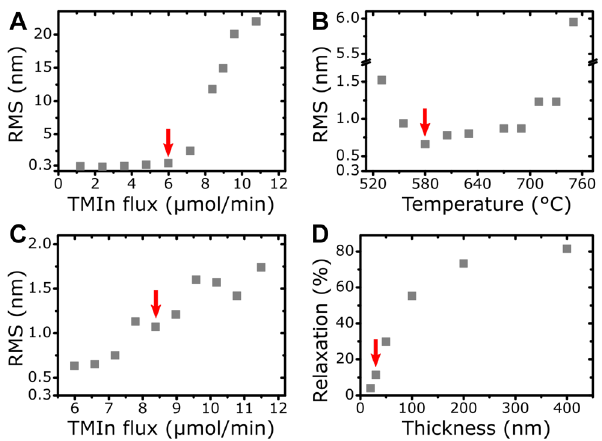
Figure 2: Successive optimization steps of growth stage I. The red arrows mark the obtained parameter